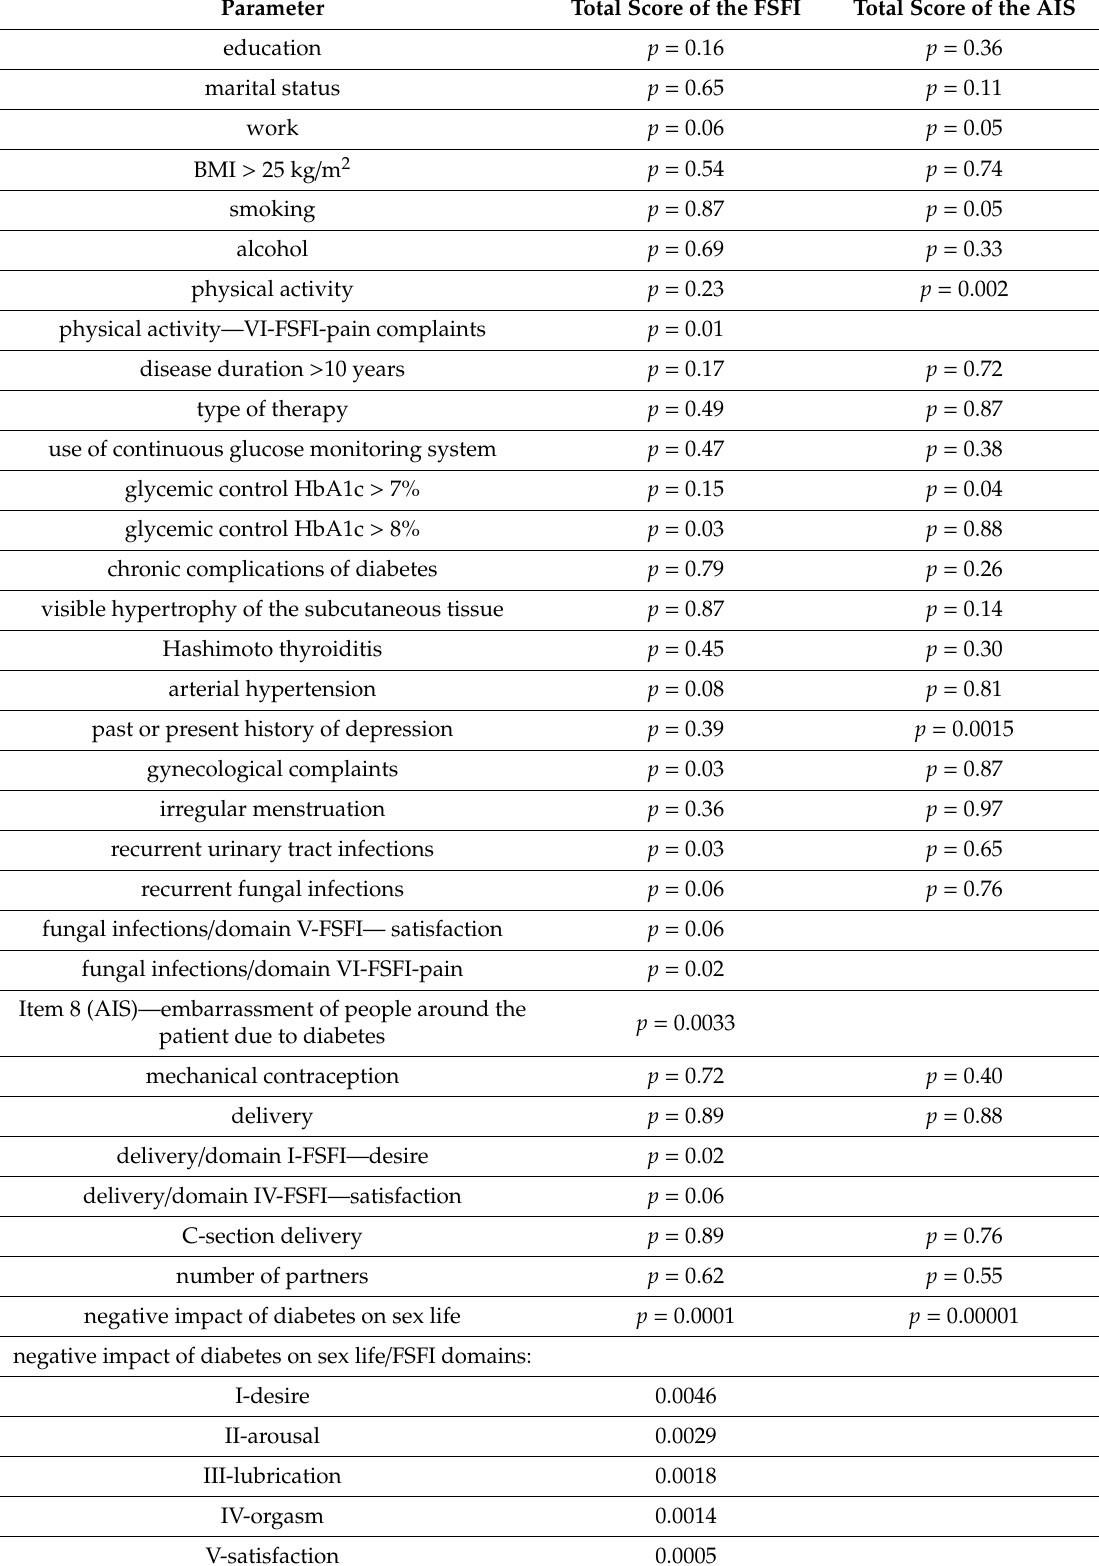
Table 4. Correlation between FSFI, AIS and the studied parameters in type 1 diabetes. Parameter Total Score of the